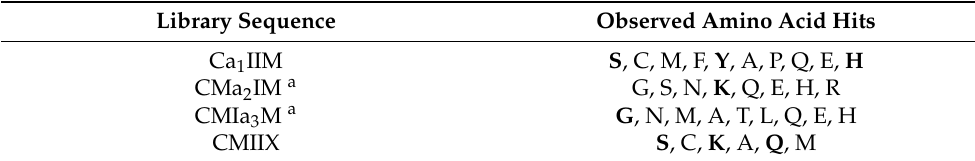
Table 1. Summary of peptides observed in MALDI-MS libraries. Peptides chosen for further evaluation are bolded.